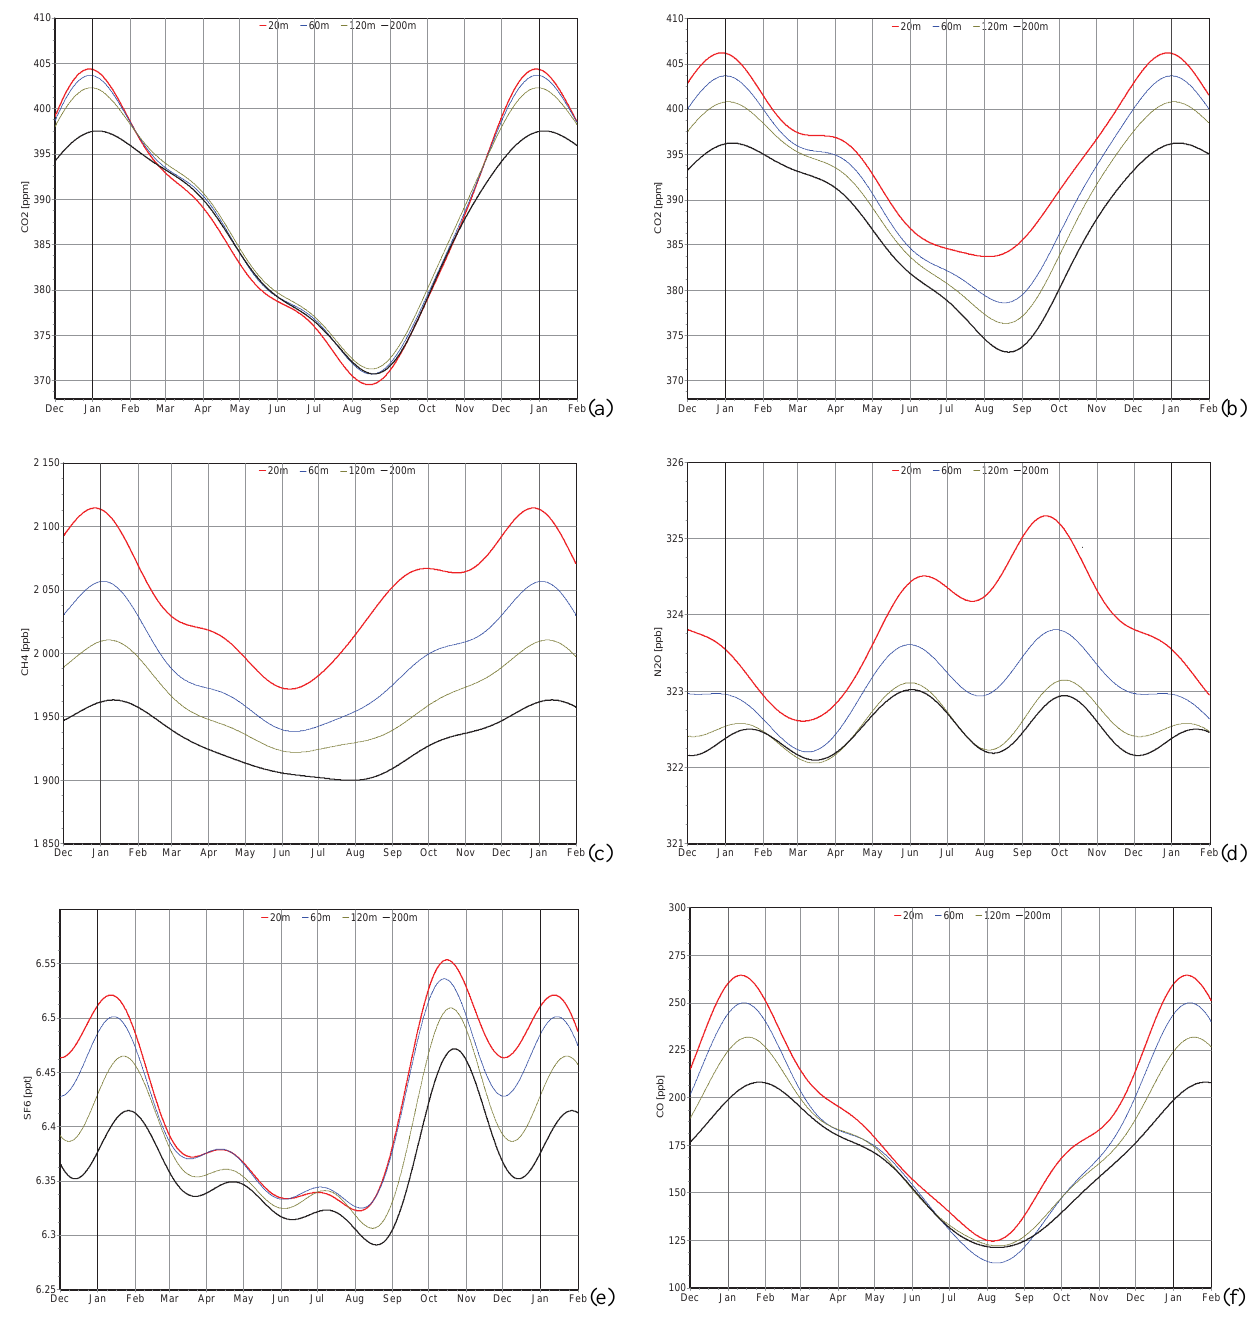
Fig. 13. Seasonal variation of the gradient of the day time minimum concentration of CO 2 (method C) (a) and the daily mean vertical gradients (all method B) of CO 2 (b) , CH 4 (c) , N 2 O (d) , SF 6 (e) and CO (f) at Cabauw. The line is the result of the fitted trend with 4 harmonics of the trimmed mean as described in Sect. 4.4, with the term for the linear trend removed. The absolute concentration is the average for the year in the middle of the measurement interval. For CO 2 and CH 4 this shows the gradient for 2005 (2000–2009 data), for the other gases the year displayed is 2007 (based on 2004–2009 data). 200 (red), 120 (blue), 60 (green) and 20 (black)